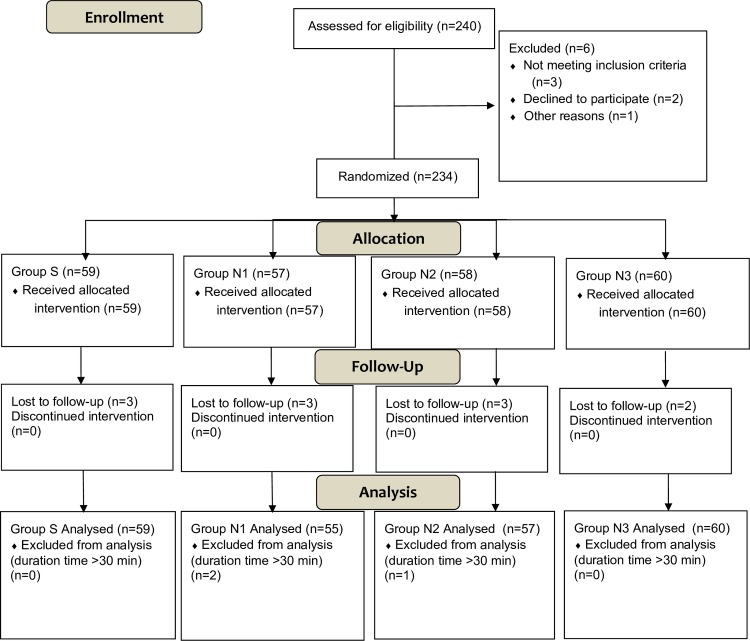
Flow chart showing the study design.